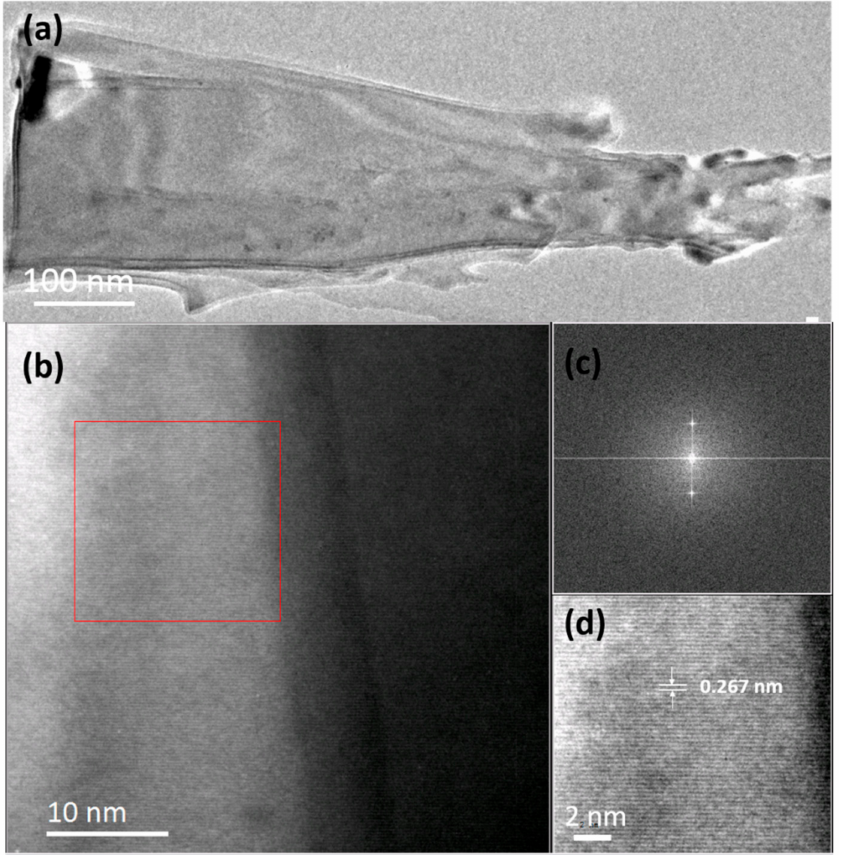
Figure 4. ( a ) Typical cross-sectional TEM imagery of a post-etched nanoarray. ( b ) HRTEM image (scale bar: 10 nm) and ( c ) corresponding FFT (Image J) of the nanostructure within the cone-shaped SiC nanoarrays of a sample etching for 20 min. ( d ) HRTEM image shows the lattice spacing in the red frame area of ( b ). (Scale bar: 2